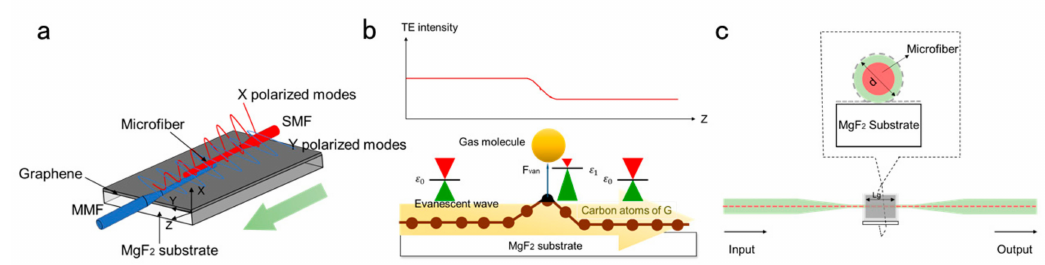
Figure 7. ( a ) Schematic of a hybrid graphene-waveguide coupled with a silica microfiber (GWMF) structure (the red curve shows TM mode and the blue curve shows the TE mode). ( b ) Working principle of GWMF for chemical vapor gas sensing. ( c ) Schematic diagram of the graphene multimode fiber interferometer (GMMI): Monolayer graphene film (honeycombs) coated on the microfiber set on the MgF 2